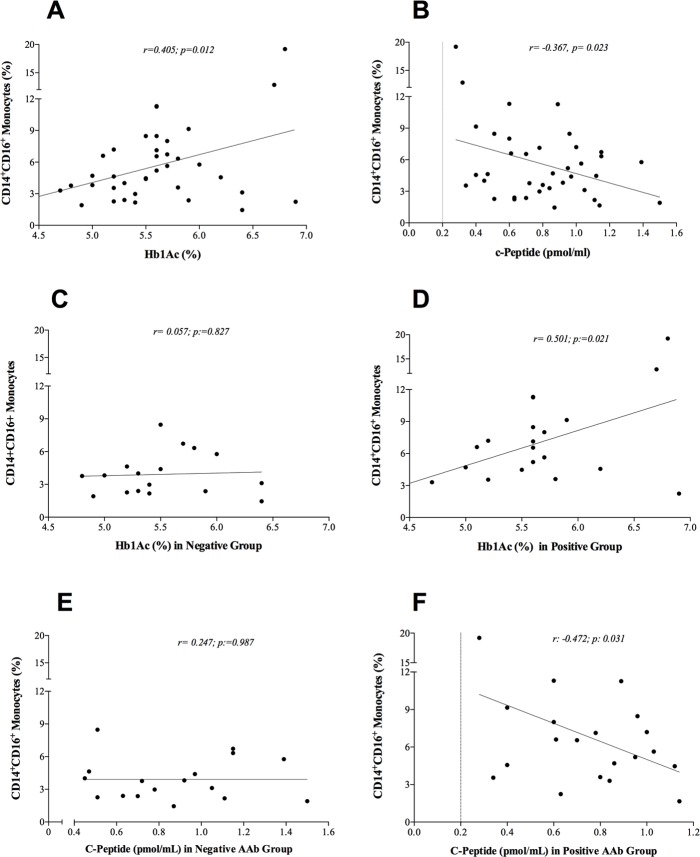
Plots showing the correlations between glycated hemoglobin, c-peptide serum levels, and monocytes.The continuous line represents the regression line. Correlation between the CD14+CD16+ monocytes and Hb1Ac levels (A) and c-Pep serum levels (B). Patients were stratified according to the positivity or negativity of pancreatic AAb. Among patients with negative AAb, Hb1Ac and C-Pep serum levels showed no correlation with the CD14+CD16+ monocytes (C and E). On the contrary, these correlations remained significant among those with positive AAb (D and F).